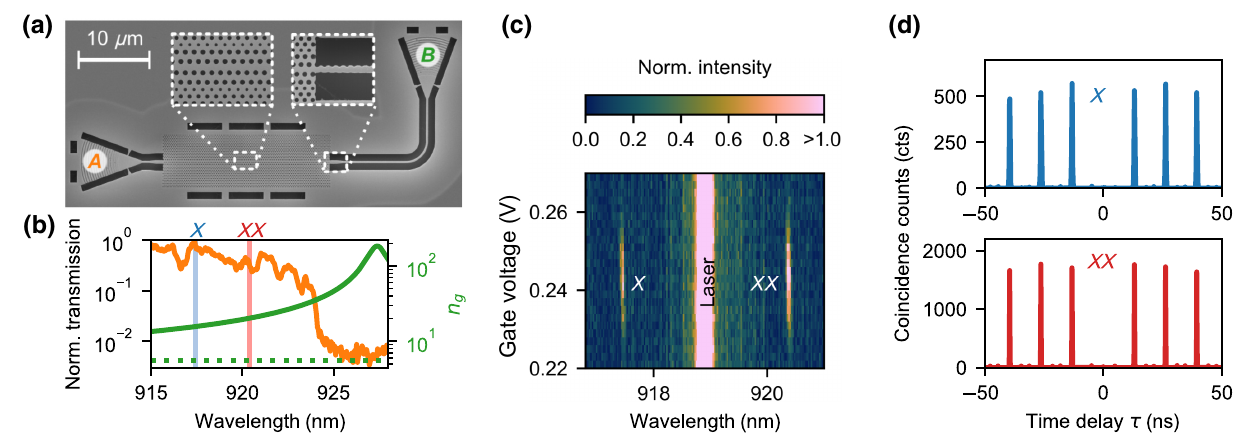
FIG. 2. Experimental characterization of QD coupled to a GPW. (a) Scanning electron microscope image of the device used for the measurements. The central section consists of a GPW (insets show close ups of the optimized waveguide design). The GPWs are connected to grating outcouplers A and B via nanobeam waveguides. The GPW-nanobeam interface features a mode adapter, as shown in the inset. (b) Spectrally resolved laser transmission shown in orange from gratings A to B for identifying the slow-light region. The curve is normalized to the transmission through a nanobeam waveguide (cf. Sec. S1 within the Supplemental Material [21]). The green curves are the simulated group index n g for the GPW (solid line) and a nanobeam waveguide (dotted line). The wavelengths of the X and XX transitions of the QD are marked as well. (c) Gate-voltage-dependent resonance fluorescence of the QD under two-photon pulsed excitation displaying the X and XX transitions. (d) Pulsed second-order correlation measurements of X and XX transitions ( 0 ) = 0.006 ± 0.002 and g ( 2 ) ( 0 ) = 0.009 + 0.014 after spectral filtering of each transition (22-GHz bandwidth). We extract g ( 2 ) − 0.009 for the X XX two transitions indicating excellent single-photon